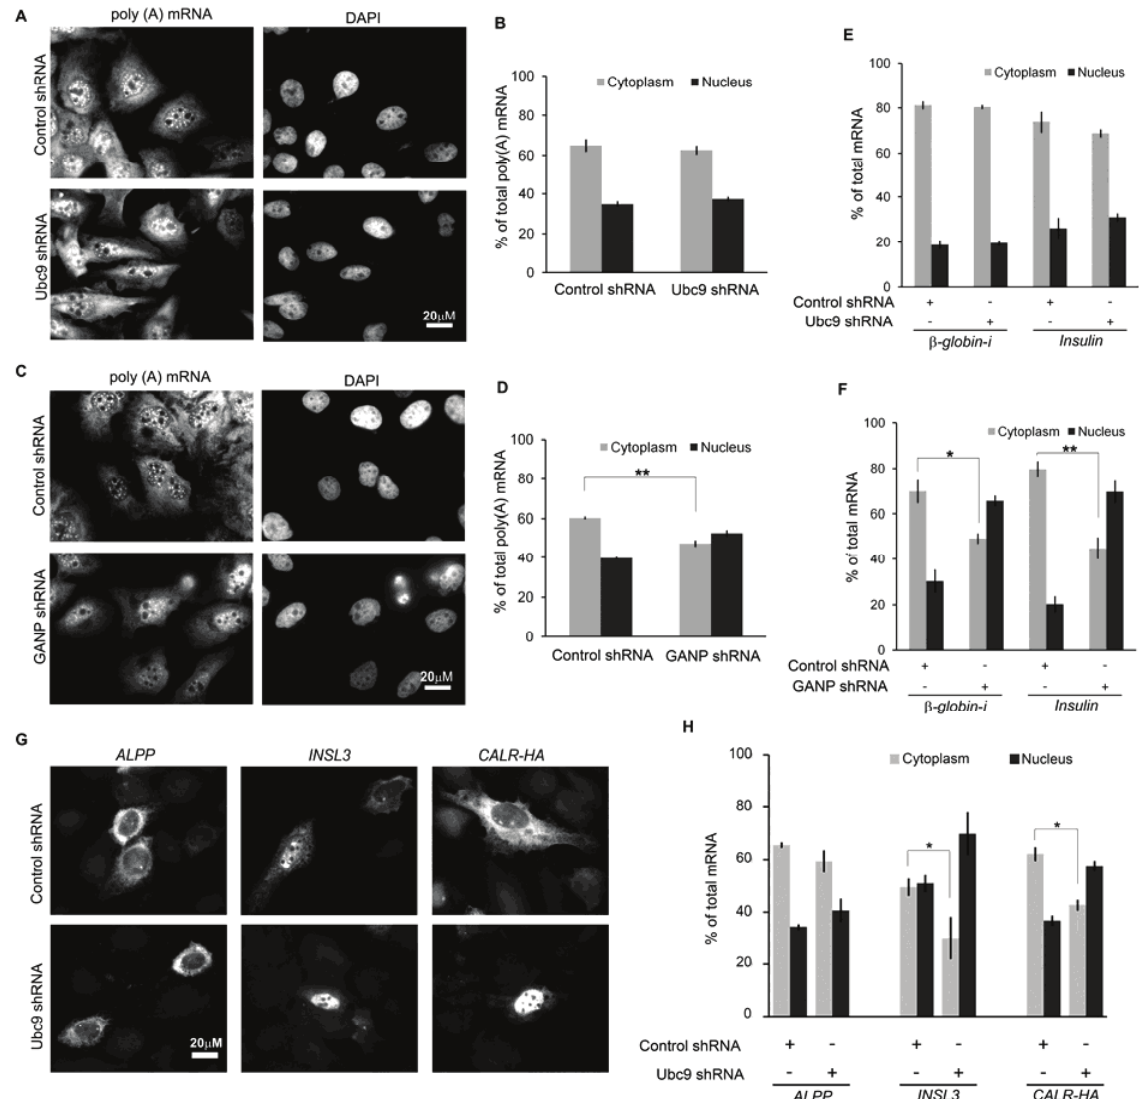
Figure 2. The effect of Ubc9 and GANP depletion on the distribution of poly(A) mRNA and other model transcripts. U2OS cells were infected with lentiviruses, which delivered plasmids containing control shRNA or pairs of shRNAs against Ubc9 or GANP, as in Figure 1A–D. Four (GANP) or five (Ubc9) days post-infection, cells were stained with oligo-dT probes and 4',6-diamidino-2-phenylindole (DAPI) as described previously [27]. Representative examples ( A , C ) and quantification summary ( B , D ) of the poly(A) mRNA distribution by FISH are shown. Note that each row in A and C represents a single field of view imaged for poly(A) and DNA. Each bar is an average and standard error of three independent experiments, each consisting of 60–90 cells. ( E – H ) Depleted cells were transfected as in Figure 1, but this time with plasmids containing either (cid:3) -globin-i , an intronless version of insulin , placental alkaline phosphatase ( ALPP ), insulin-like 3 ( INSL3 ) or HA-tagged calreticulin ( CALR-HA ). After allowing expression for 18–24 h, cells were fixed and stained with specific FISH probes against each mRNA. Representative examples ( G ) and quantification summaries ( E , F and H ) of the cytoplasmic and nuclear integrated fluorescence intensity for each mRNA are shown, with each bar representing an average of three independent experiments in which 40–60 cells were used in each experiment. * p < 0.05, ** p <